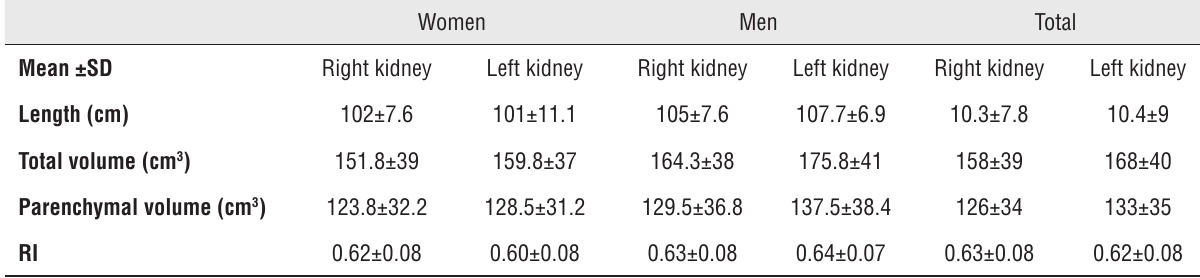
Table 2 - Mean kidney length, volume and RI.